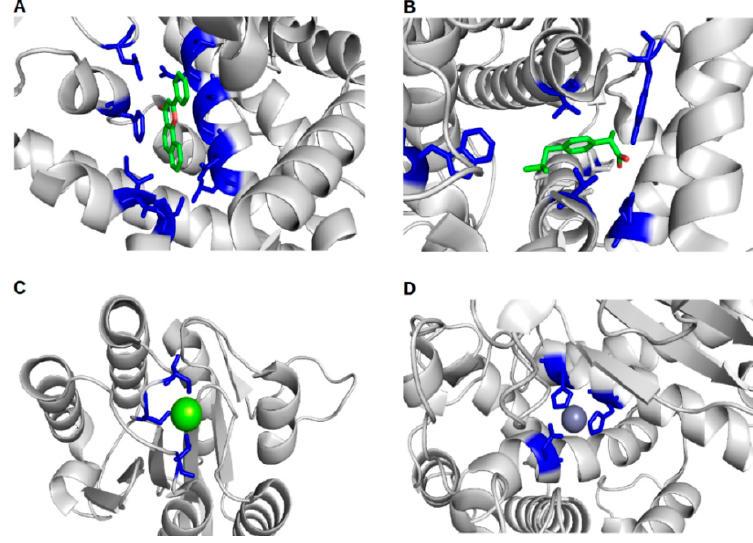
Figure 1. Examples of protein–ligand interactions, focusing on the ligand binding site. Proteins are shown in cartoon form and coloured in light grey, with binding site residues shown as blue sticks, and ligands shown as sticks or spheres coloured by element; ( A ) The Human cytochrome P450 1A1 protein (PDB ID 4i8v) bound to the drug N -Benzylformamide; ( B ) Cyclooxygenase-2 (PDB ID 4ph9) from Mus musculus bound to the drug Ibuprofen; ( C ) The Plasmodium vivax TRAP protein (PDB ID 4hqo, CASP ID T0686) bound to magnesium and; ( D ) The aminopeptidase N family protein Q5QTY1 (PDB ID 4fgm, CASP ID T0726) from Idiomarina loihiensis bound to zinc (a cofactor).